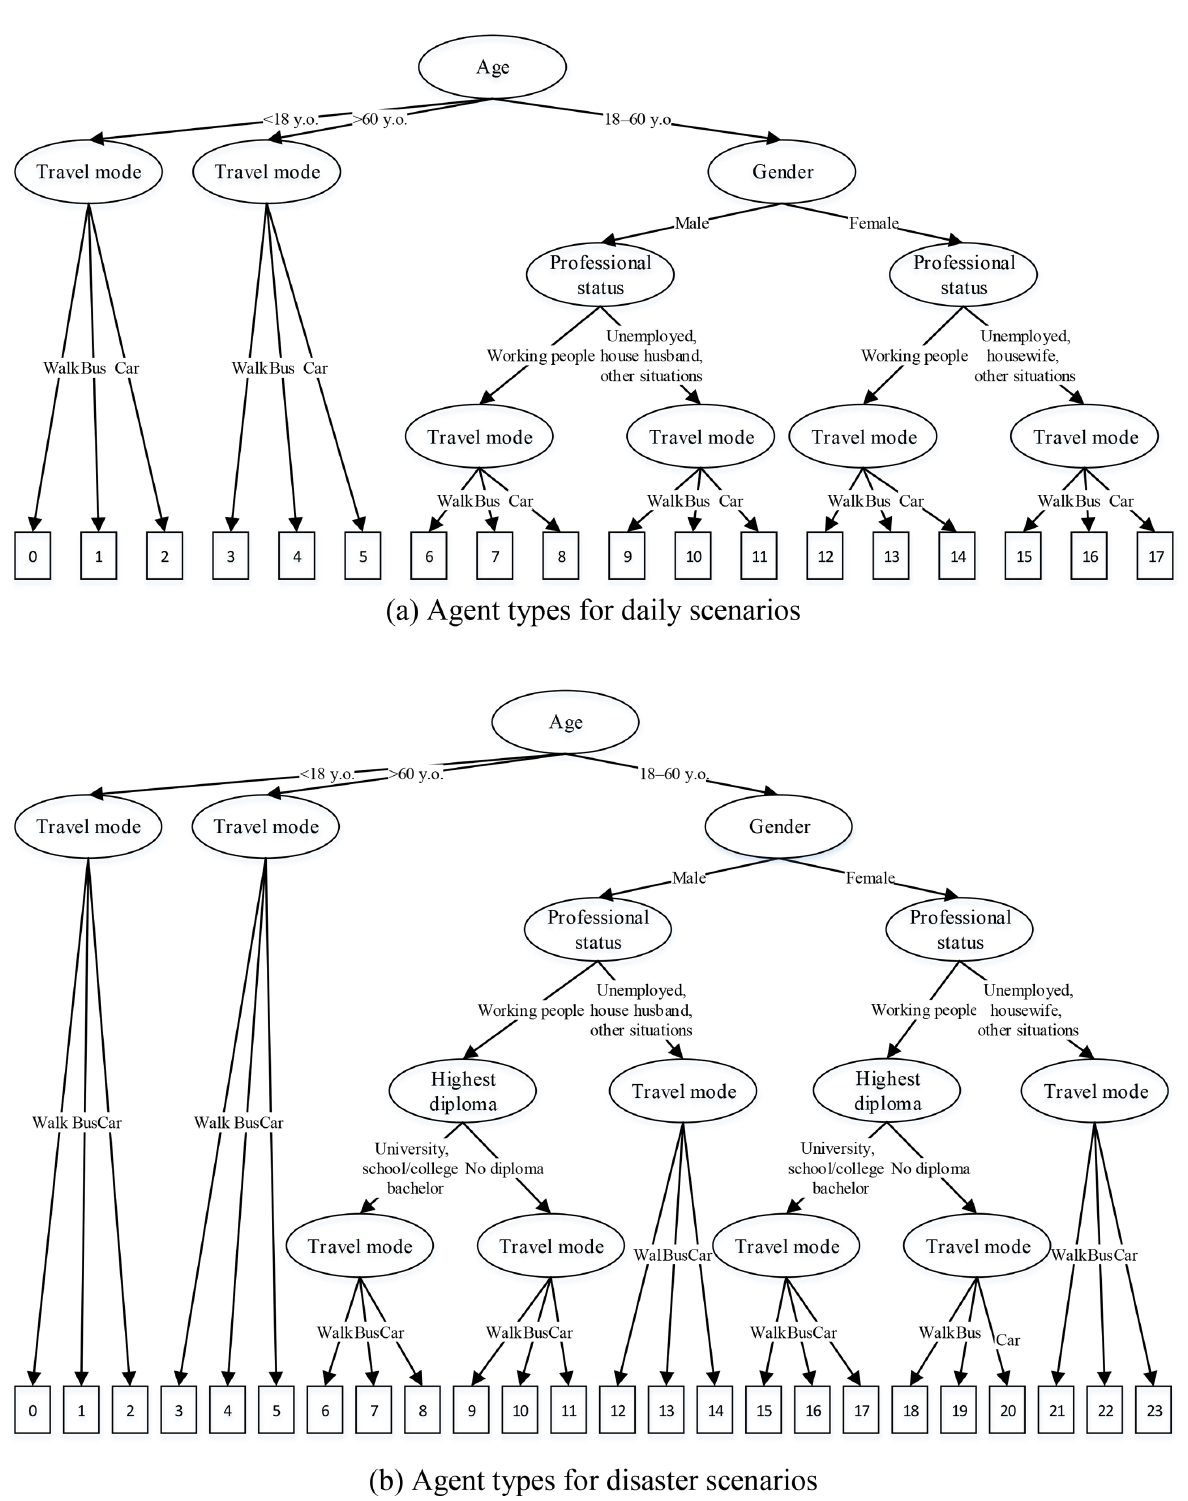
Figure 8. Agent types for daily and disaster scenarios. Daily scenarios refer to S1, S2, S7, and S8. Others are disaster scenarios.